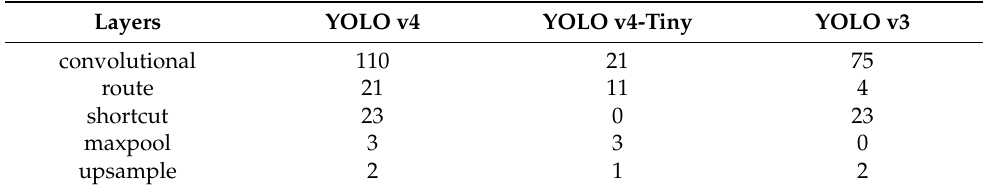
Table 2. The training layers of YOLO v4, YOLO v4-tiny, and YOLO v3.